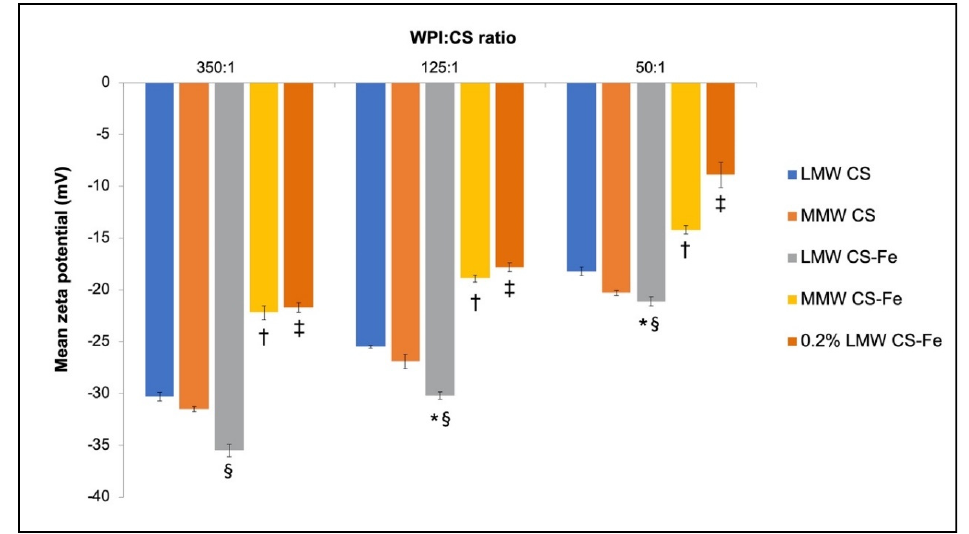
Figure 9. Zeta potential of iron-entrapped WPI nanoparticles when using different MWs and concentrations of chitosan at various WPI:CS ratios. Results are shown as mean ± SD (n = 3). Data were considered statistically different when p < 0.05. * indicates a significant difference comparing 350:1 LMW CS to LMW CS at other ratios, † indicates a significant difference between LMW CS-Fe and MMW CS-Fe at the same ratio, ‡ indicates a significant difference between LMW CS-Fe and 0.2% LMW CS-Fe at the same ratio, § indicates a significant difference between LMW CS and LMW CS-Fe at the same ratio.